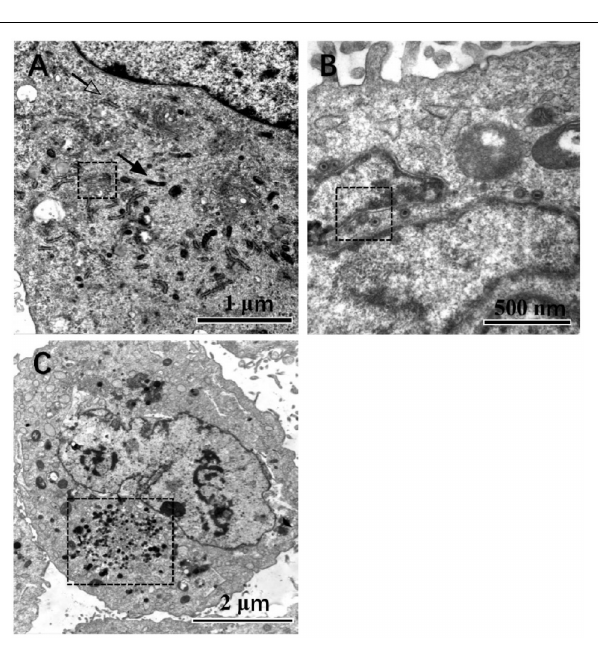
FIGURE 3 | Cells observed under the TEM, magnification is marked. In mock-infected cells (A) , those pointed by the solid arrow and hollow arrow point are mitochondrion and endoplasmic reticulum, respectively. The organelle in the dotted line box is the Golgi complex. In HCMV infected cells (B) , the nuclear egress complex is in the dotted line box. In contrast, VAC is found in the infected cells next to the nuclear and indicated by the dotted line box (C) , at a magnification of 20,000, 40,000, and 80,000,